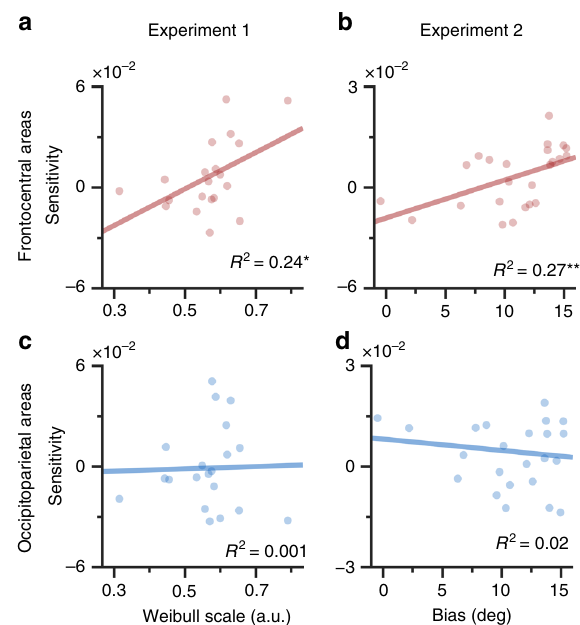
Fig. 7 Frontocentral areas showed signi fi cant correlations between reconstructions and ensemble behavior, while occipitoparietal areas showed no correlations. a – b Orientation sensitivities of SO – VO predictions in frontocentral areas showed correlation with ensemble behavior. a Results of Experiment 1. Behavioral index of Experiment 1 was calculated by fi tting a cumulative Weibull model to the results of the VO condition and getting a threshold parameter. b Results of Experiment 2. Behavioral index of Experiment 2 was the average biases of four target orientations. c – d Orientation sensitivities of SO – VO predictions in occipitoparietal areas did not show correlation with ensemble behavior. c Results of Experiment 1. d Results of Experiment 2. Each data point represents the data of one participant. The x -axis shows behavioral index, and the y -axis shows the orientation sensitivities. Lines show the regression line. * p < 0.05, ** p < 0.01. SO same orientation, VO varied